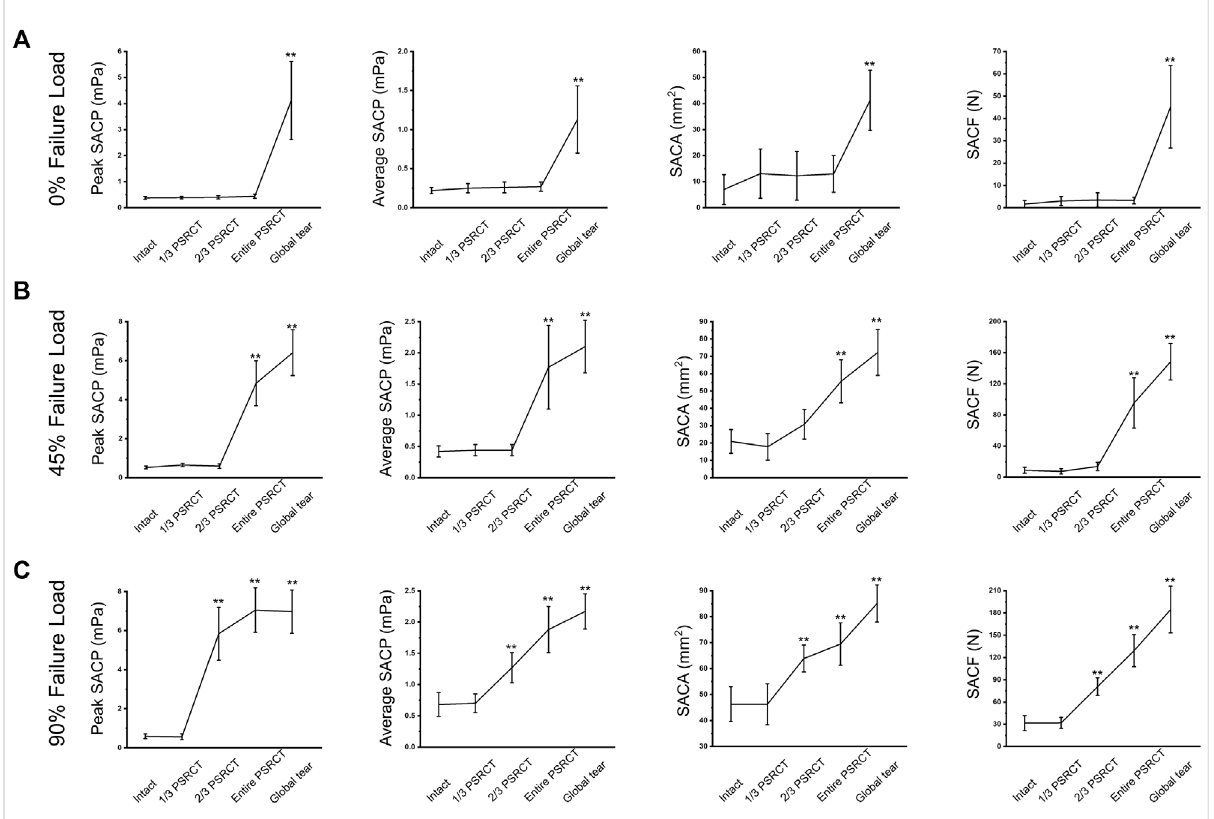
FIGURE 5 Effect of RCT on the peak and average SACPs, SACA, and SACF under (A) 0, (B) 45, and (C) 90% failure loads during abduction. SACP, subacromial contact pressure; SACA, subacromial contact area; SACF, subacromial contact force. **, a signi fi cant difference compared with the intact condition, p < 0.01.